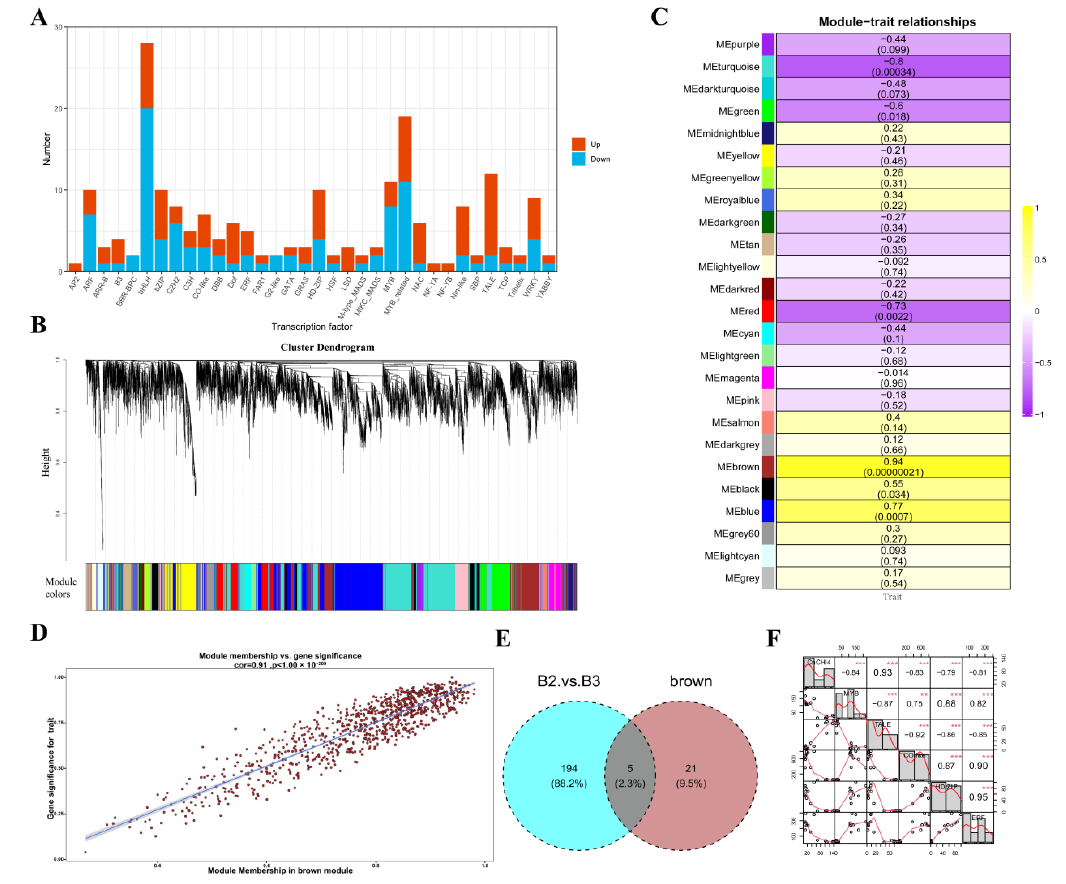
Figure 7. Identification of the transcription factors that regulate CnCHI4 expression. ( A ) Transcrip- tion factors that were differentially expressed between B2 and B3; the red and blue bars represent upregulated and downregulated expression in B3 stage, respectively. ‘Transcription factor’ on the x-axis represents different transcription factor families, and ‘number’ on the y -axis means the num- ber of DEGs detected within each gene family. ( B ) Hierarchical cluster tree of the co-expressed mod- ules. ( C ) Correlation between the gene expression modules and the expression level of CnCHI4 at different stages of flower development, the number in the brackets represents significance level. The bar ranging from purple to yellow ( −1 to 1) represents negative to positive correlations,